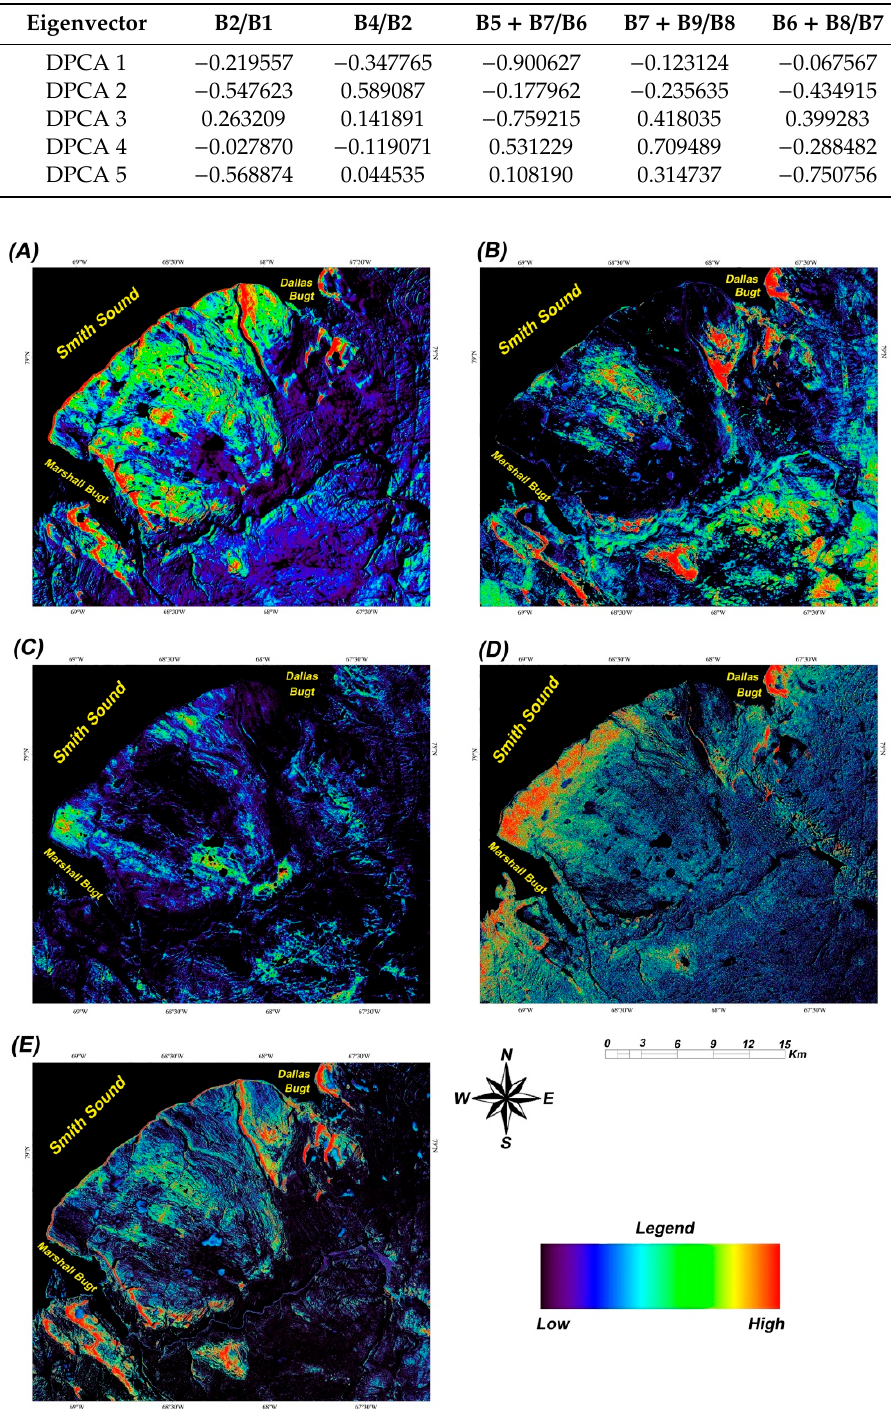
Table 3. Eigenvector matrix of the ASTER VNIR + SWIR band ratio indices derived from the DPCA for the selected subset covering the Cu-Au mineralization belt and surrounding